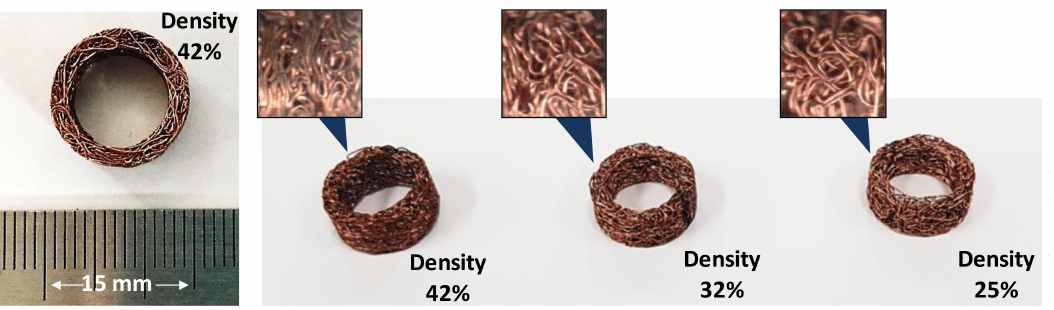
Figure 4. Photographs of test copper